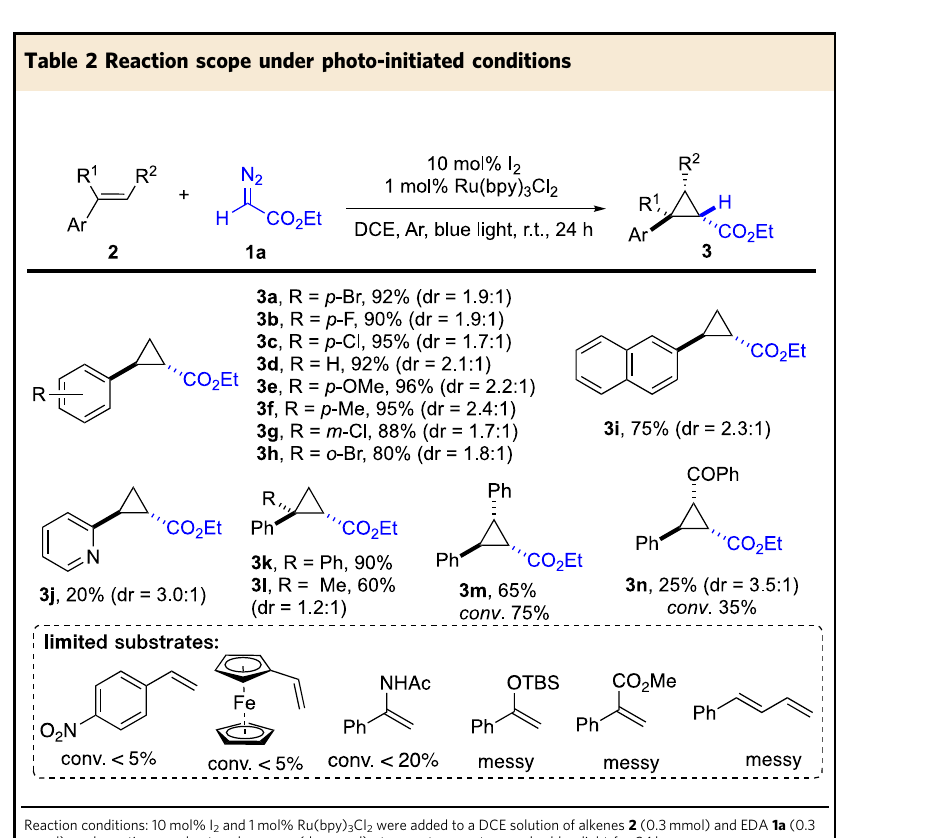
Table 2 Reaction scope under photo-initiated conditions